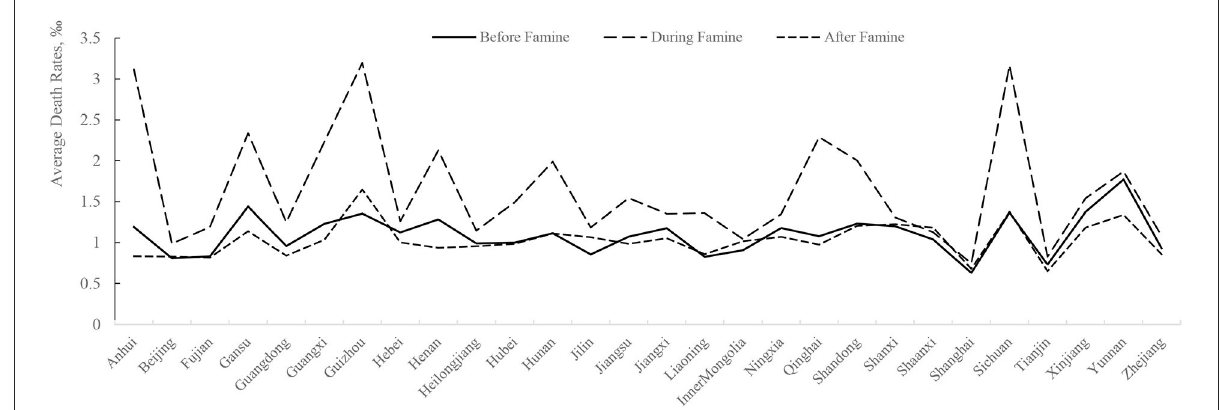
FIGURE1 Distribution of the severity of the famine by province. This figure shows the distribution of the severity of the famine by province. The sample is from 1956 to 1964. The X-axis is 28 provinces in China. Tibet is not listed because of lacking data. The Y-axis is the average mortality rate for each province. We calculate the average mortality rate in three ways: 3 years before the Great Famine , 3 years during the Great Famine , and 3 years after the Great Famine